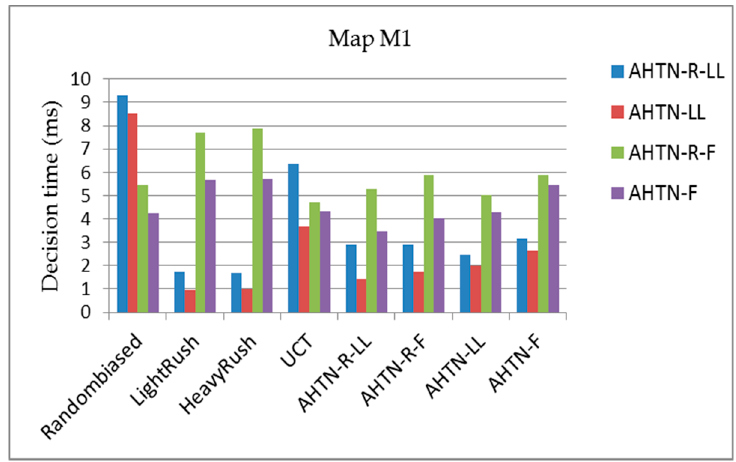
Figure 10. The average decision times of AHTN-R and AHTN with the two types of HTNs obtained over 100 games against each of the 8 algorithms, where the CPU time is 100 ms for map M1 (8 × 8 tiles). The playout time is 100 cycles.